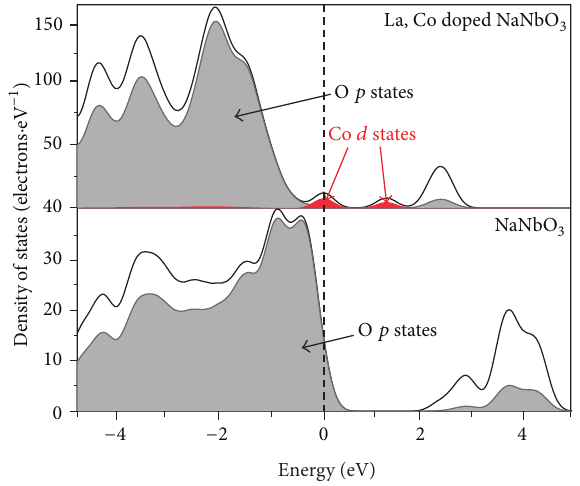
Figure5:Thecalculateddensityofstatesandpartialdensityofstates of NaNbO 3 and La, Co codoped NaNbO 3 .